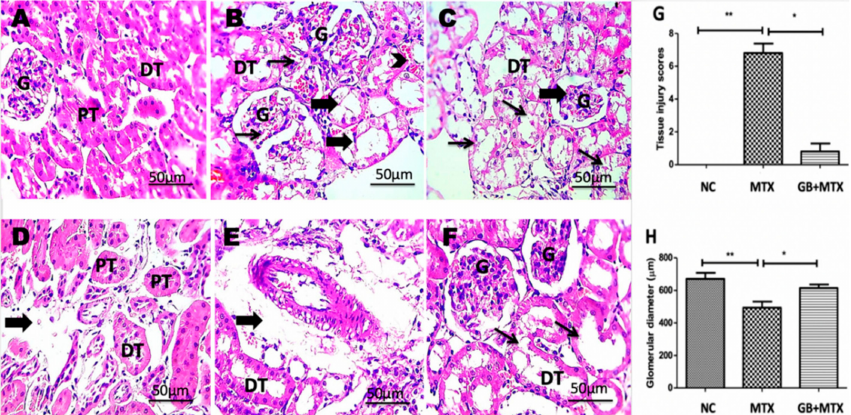
Figure 5. Kidney showing normal histological structure of renal glomeruli (G), proximal (PT) and distal (DT) tubules in NC group ( A ), congested glomeruli (thin arrows) with tubular degeneration and dilation (thick arrows), congested interstitial blood vessels (arrowhead) ( B ), shrunken glomerular tuft (thick arrow) with marked hydropic degeneration in tubular epithelium (thin arrows) ( C ), interstitial edema (thick arrow) ( D ) and perivascular edema (thick arrow) ( E ) in MTX group, tubular dilation ( F ) in GB + MTX-treated group. ( H , E ) X: 400. Statistical analysis of tissue injury scores ( G ) and glomerular diameter ( H ) in all studied groups. ** p < 0.05 versus NC group. * p < 0.05 versus MTX